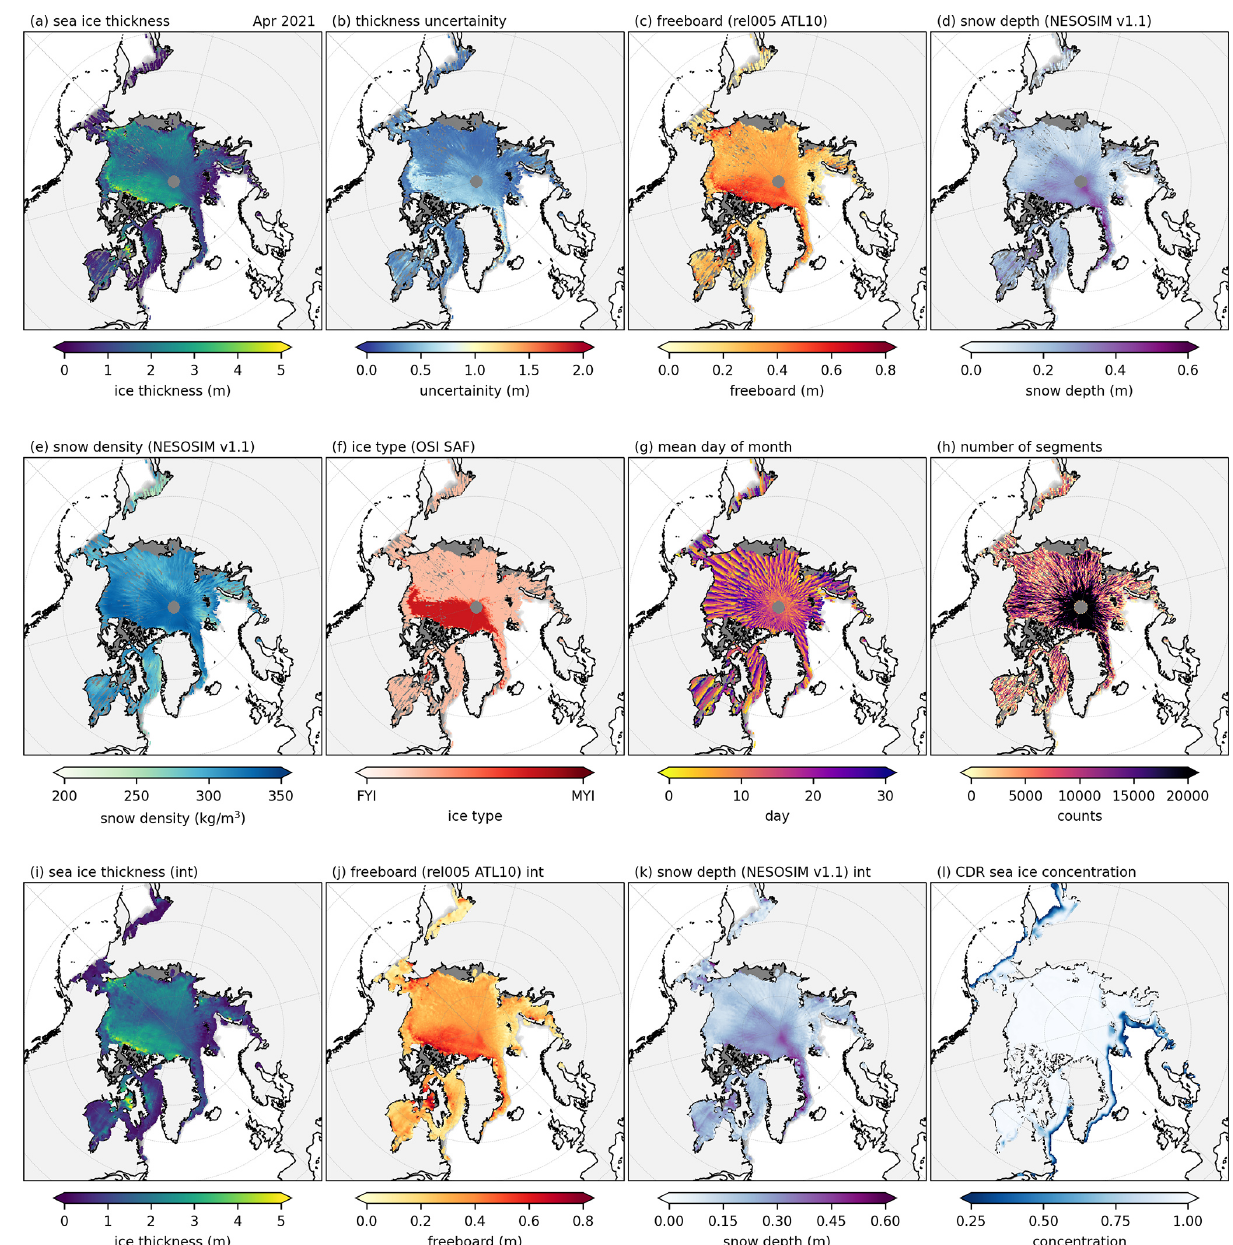
Figure 9. Example monthly mean gridded sea ice thickness dataset (IS2SITMOGR4, version 2) for April 2021. Dataset derived from rel005 ATL10 freeboards and NESOSIM v1.1 snow loading across all three strong beams. The background dark grey shading in panels (a) to (k) is the CDR sea ice concentration shown in panel (l) . Panels (i) to (k) show interpolated/smoothed